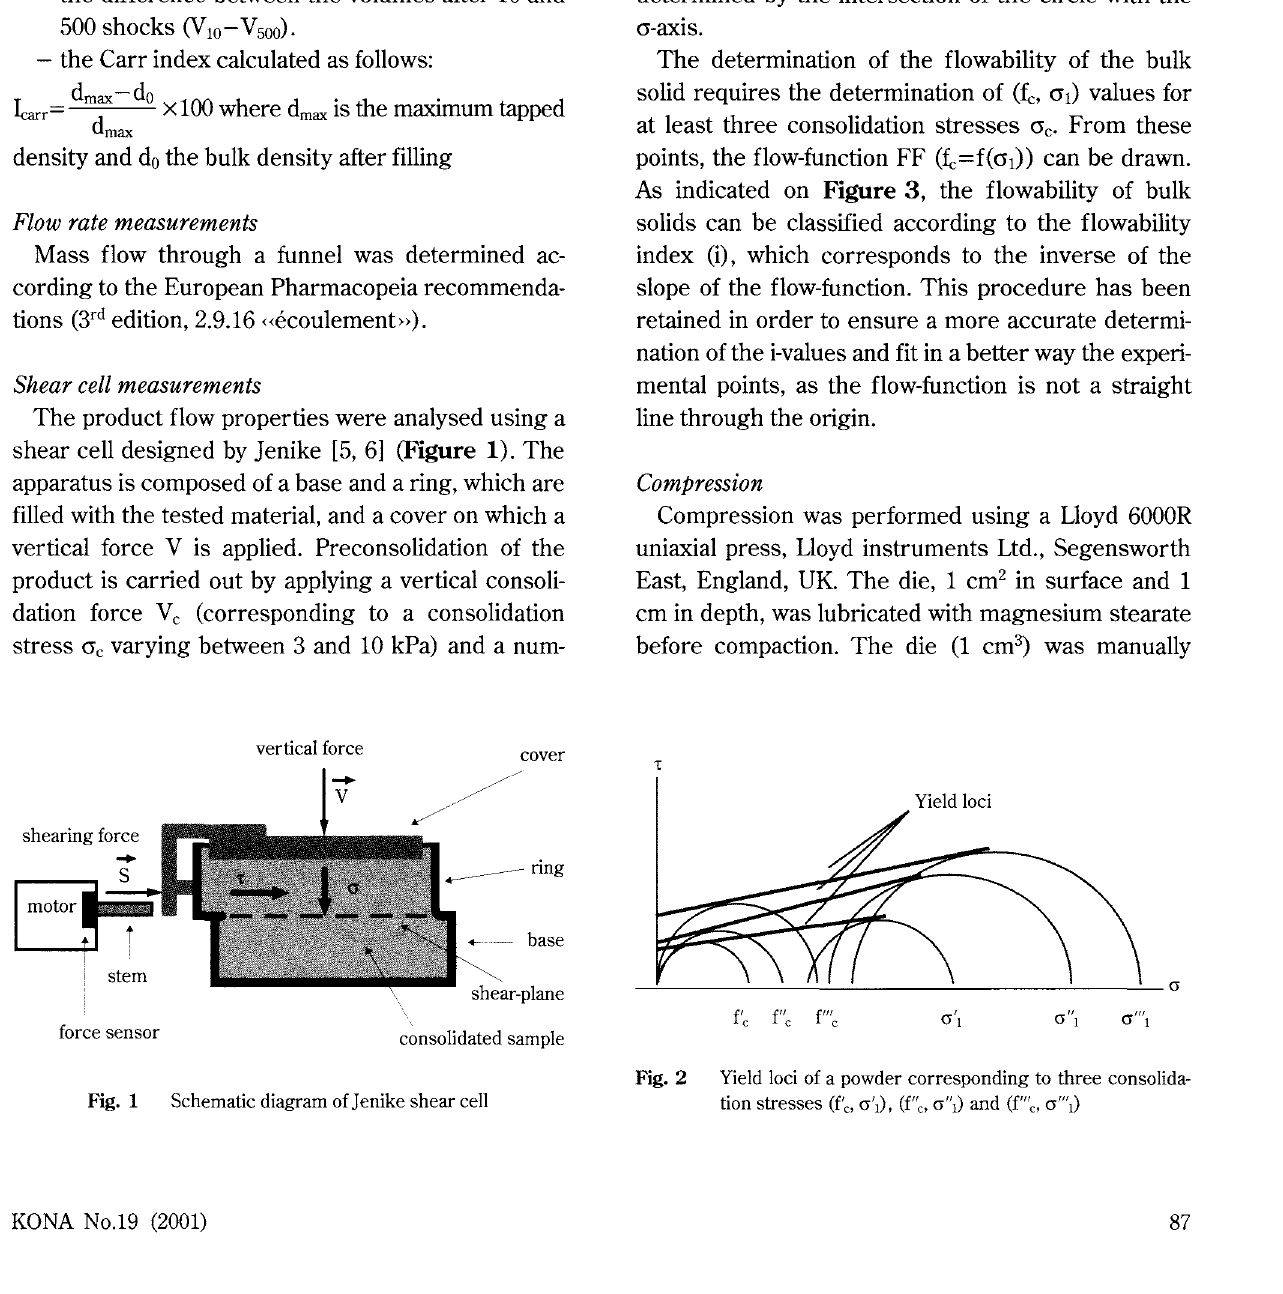
Fig. 2 Yield loci of a powder corresponding to three consolida tion stresses (f'c. cr' 1), (f",, cr'\) and (f'"c. cr"'